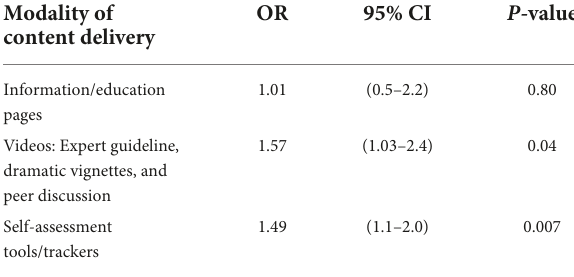
TABLE 3 Association between logon time for digital counseling modalities in sessions 1–16 and 12-month KCCQ-OS tertile.